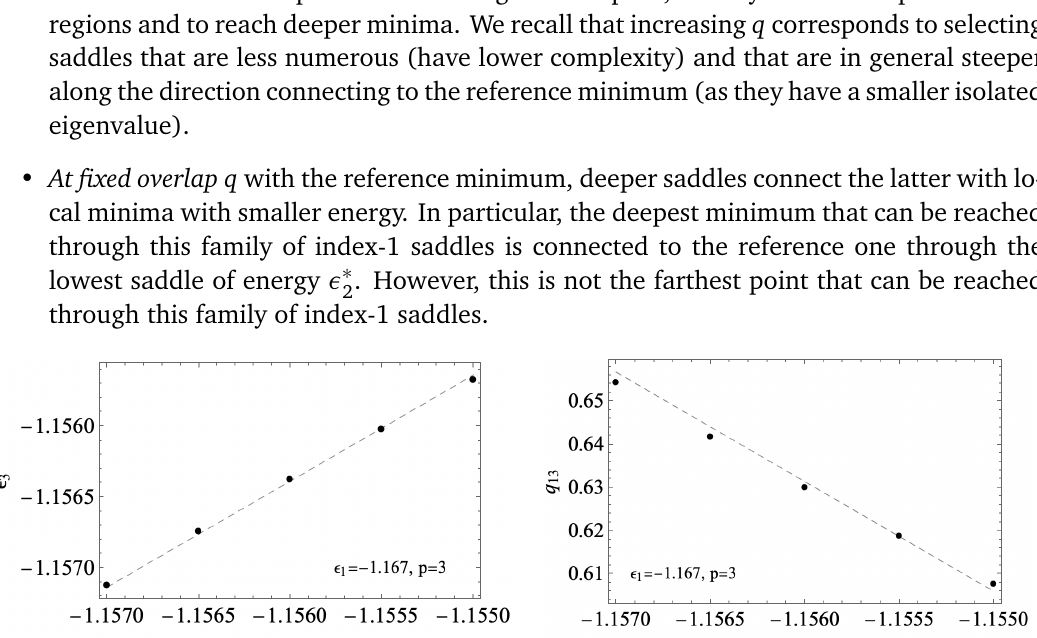
Figure 5: Left. The energy ε decreases with q , at fixed energy ε of the asymptotic overlap q decreases with q , i.e., the closer is the saddle to the reference minimum, the farther is the one reached asymptotically; for energies ε of q is non-monotonic. 13